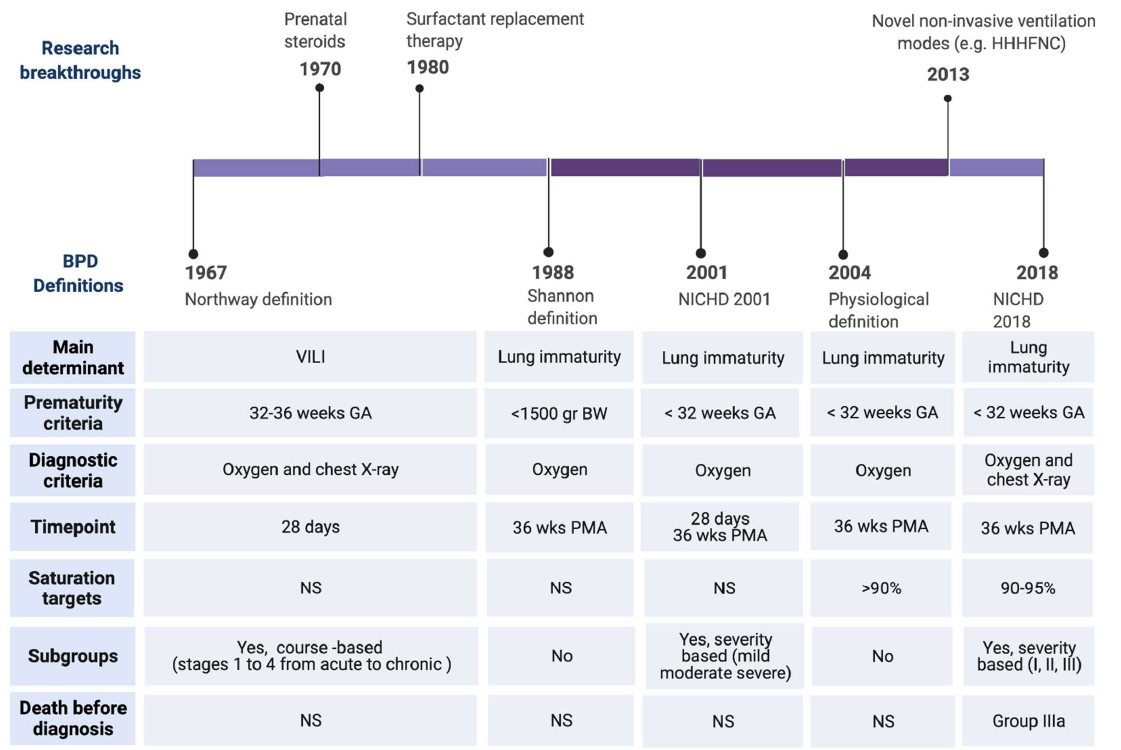
Figure 2. Timeline of BPD definitions. Upper: Major clinical breakthrough that have influenced the change of BPD definitions. Lower: Major differences among the definitions. Abbreviations: Heated, humidified, high flow nasal cannula (HHHFNC), National Institute of Child Health and Human Development (NICHD), ventilator induced lung injury (VILI), birth weight (BW), gestational age (GA), post-menstrual age (PMA). Created with BioRender.com [10 ,11,12,13,14,16,17,18 ].